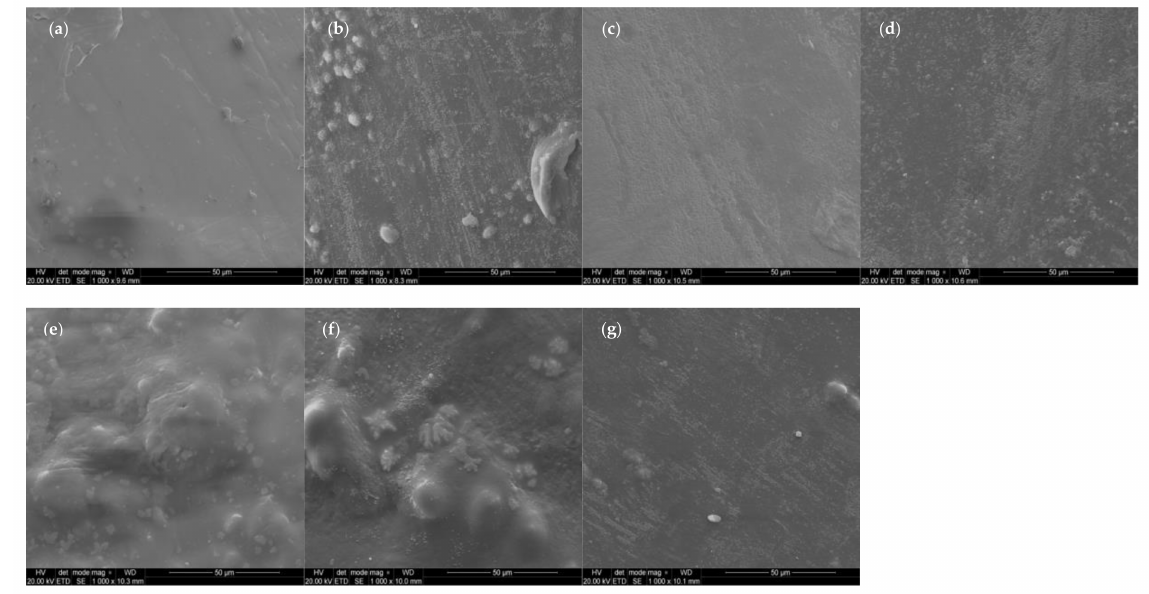
Figure 10. SEM micrographs of surfaces of neat samples: ( a ) PLA, ( b ) TPU, ( c ) COMP-2,5PLA, ( d ) COMP-5PLA, ( e ) COMP- 7,5PLA, ( f ) COMP-10PLA, ( g ) COMP-12,5PLA.